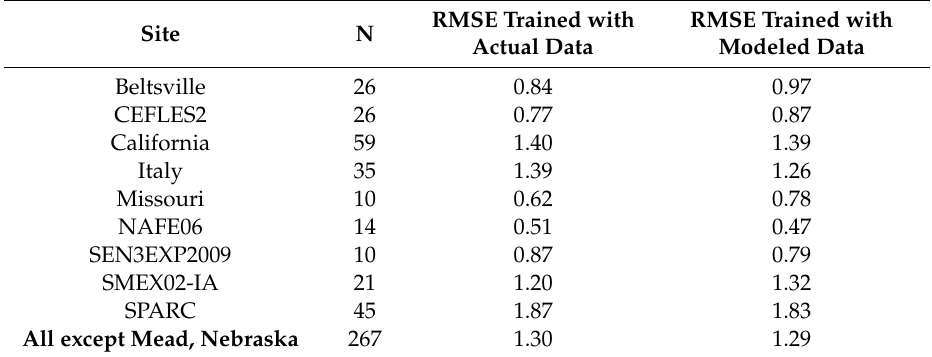
Table 7. Comparison of LUE Canopy retrieval performance on all sites except Mead, Nebraska in FLUX dataset trained with actual and HM-modeled Mead, Nebraska LUE Canopy values. RMSE Trained with RMSE Trained Site N Actual Data